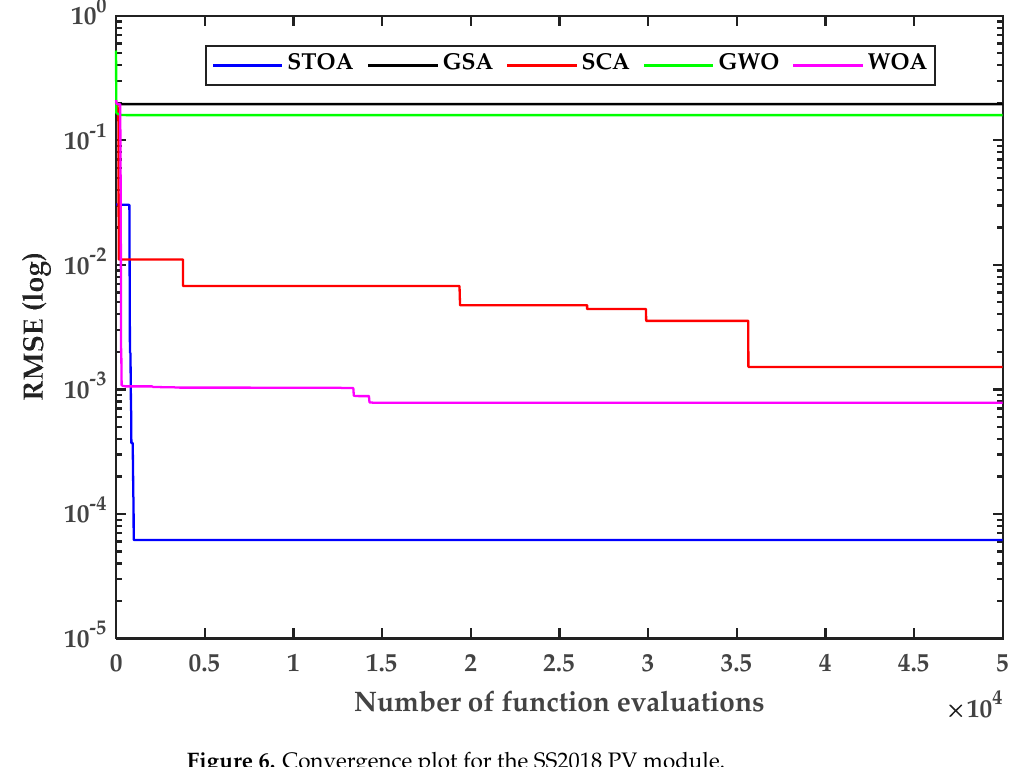
Figure 5. Convergence plot for the RTC France solar cell.